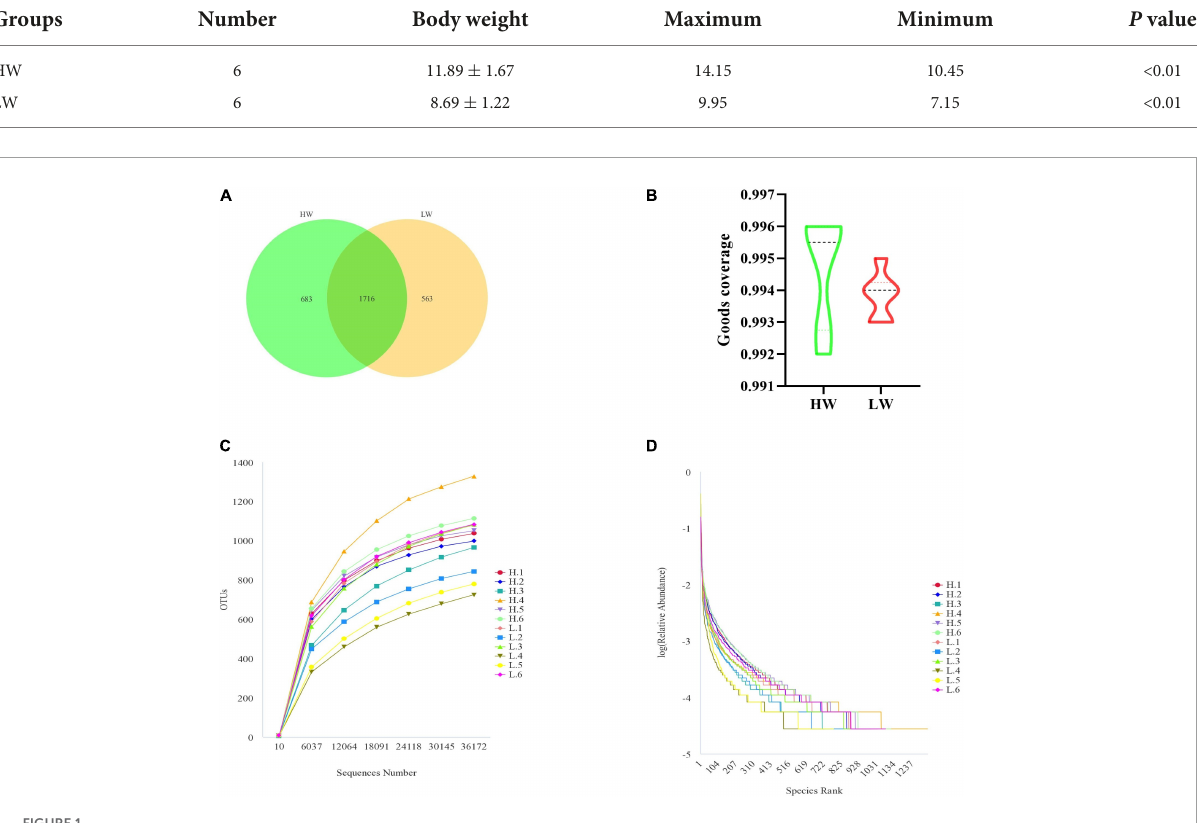
TABLE 1 Body weights of the Hainan black goats used in this study.